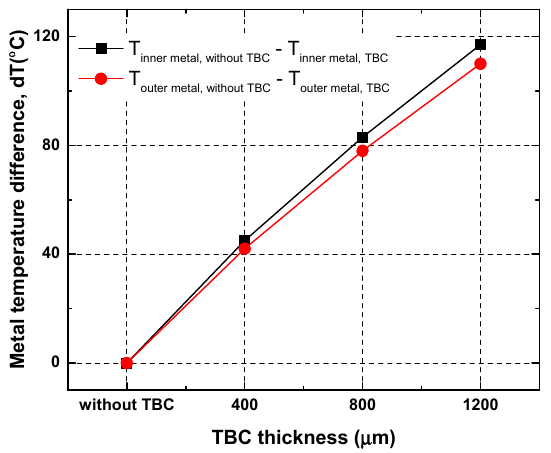
Figure 17. Temperature difference between without TBC and three different TBC thicknesses. Figure 16 shows that the dT between the TBC surface and inner metal surface was increased linearly; the correlation is expressed in Equation (8). The dT between the inner metal and outer metal surface was around 4%, and thus, had not changed remarkably between the TBC thicknesses. This is due to the low thermal conductivity of the YSZ material coated inside the CL, which slows the thermal conduction rate from the TBC surface to the inner metal surface, and the dT can, thereby, provide a thermal barrier to the CL. As a result of the effectiveness of varying TBC thicknesses, a total temperature reduction between the TBC surface and the outer metal was increased. Additionally, the dT comparison of all three TBC thickness cases with no TBC thickness case is shown in Figure 17. As previously stated, the inner and outer metal temperature decreased as the TBC thickness increased, which increased the dT of the inner and outer metal between without TBC and TBC thickness, as shown in Figure 17. The percentage of decrease in the inner metal temperature based on TBC was calculated using Equation (9), and it is shown in Figure 18: